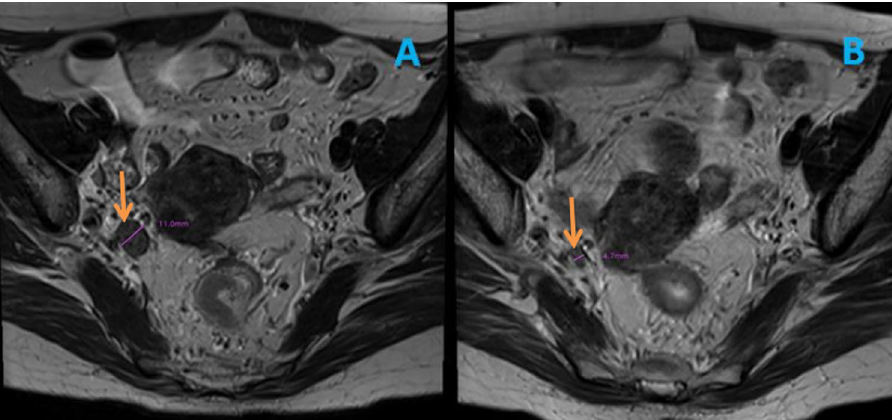
Fig. 1 The image of suspected positive LLN and the measurement of the maximum short-axis before and after nCRT. nCRT neoadjuvant chemoradiotherapy; LLN lateral lymph node. A The yellow arrow points to a suspected positive lateral lymph nodes in internal iliac before long-term neoadjuvant chemoradiotherapy with a maximum short-axis of 11.0 mm. B The yellow arrow points to the images corresponding to the LLN in Figure A after long-term neoadjuvant chemoradiotherapy, with a maximum short-axis of 4.7 mm